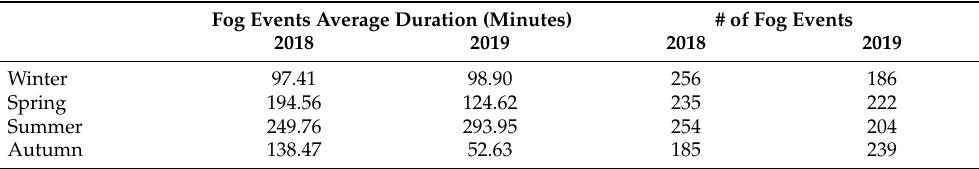
Table 8. Low-visibility events statistics at Mondoñedo station for the years 2018 and 2019, for the 300 m threshold.